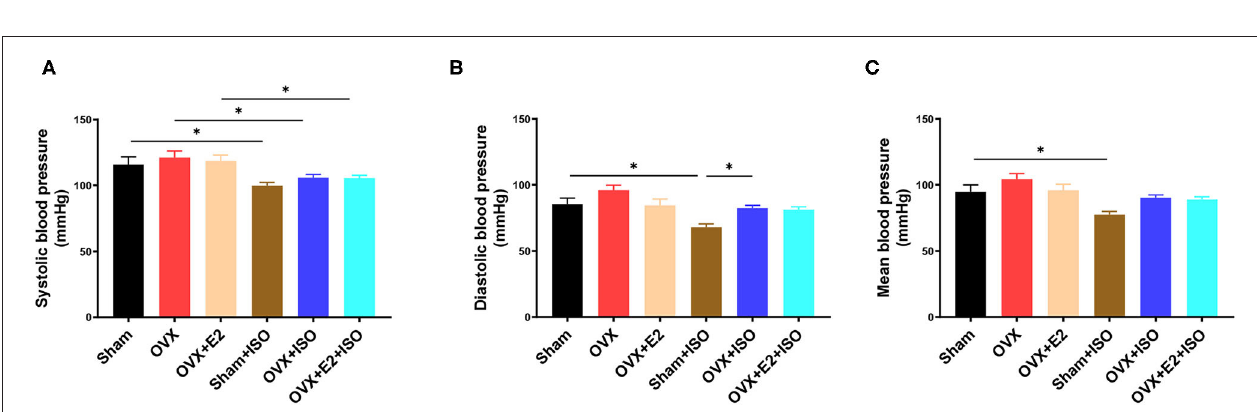
FIGURE 1 | Estrogen prevents excessive body weight gain during catecholamine stress. (A) The heart weight. (B) The body weight. Results are presented as mean ± SEM. N = 8. * P < 0.05, ** P < 0.01, and *** P < 0.001.